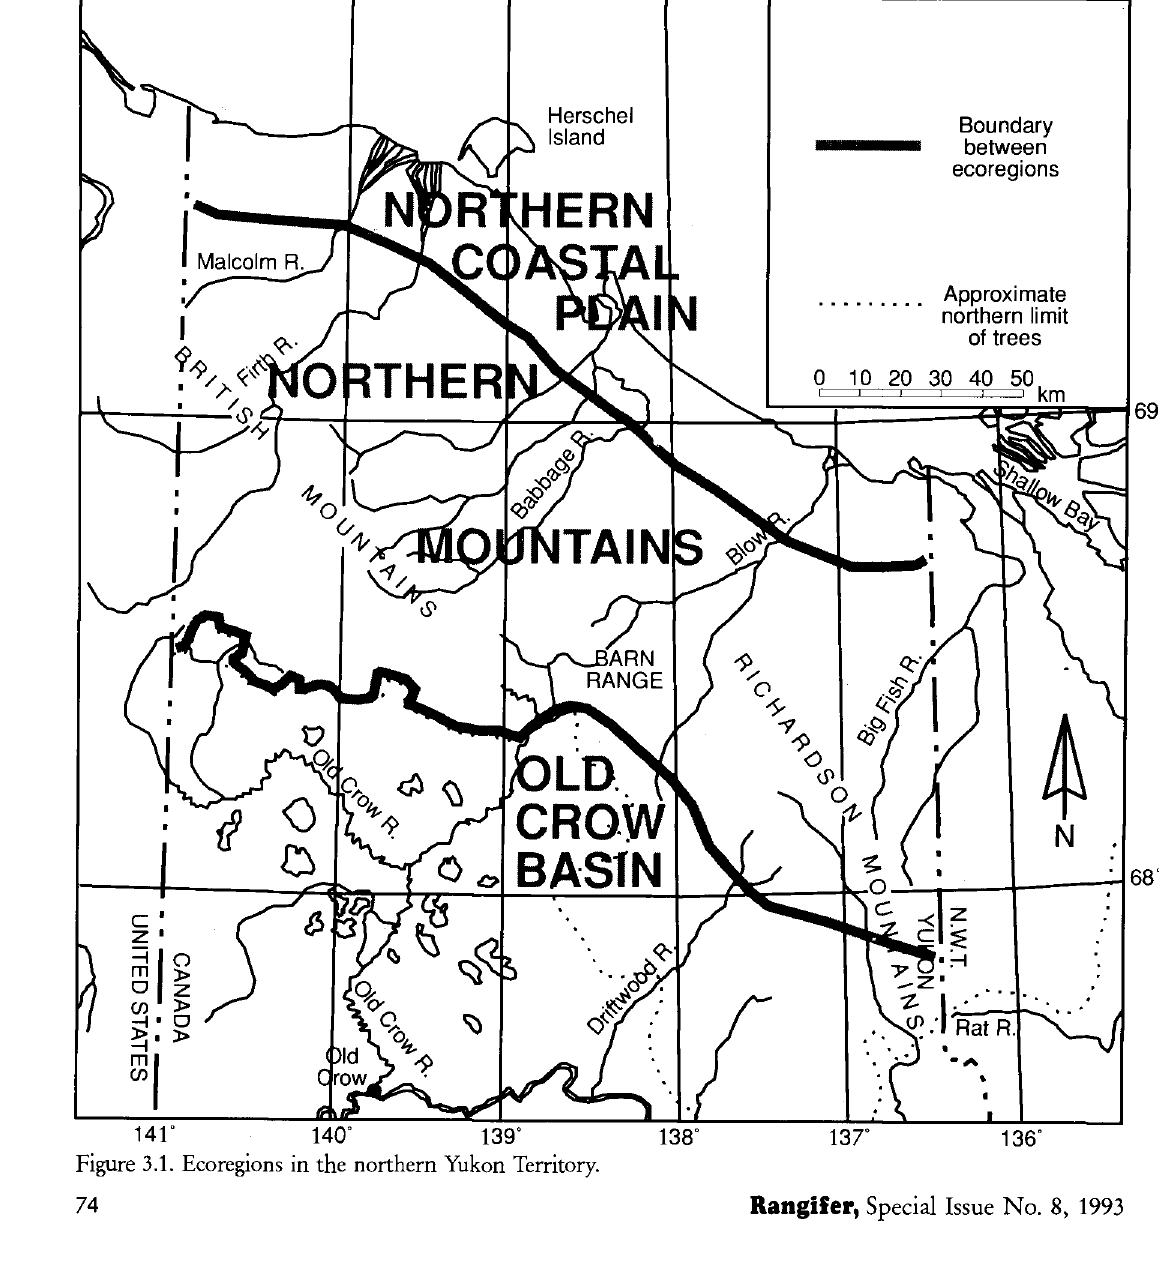
Figure 3 .1. Ecoregions in the northern Yukon